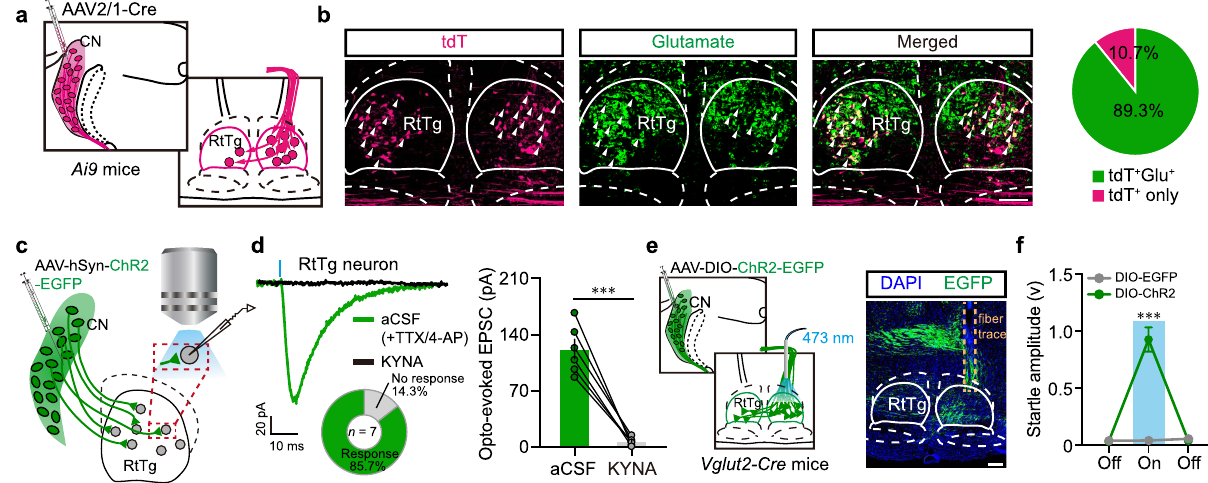
Fig. 5 The CN sends monosynaptic glutamatergic projections to RtTg glutamatergic neurons. a Schematic for the anterograde tracing from CN to RtTg. b Left: representative images showing RtTg tdT + neurons co-labelled with glutamate (white arrowheads). Scale bar, 300 μ m. Right: pie chart indicating the percentage of RtTg tdT + neurons co-labelled with or without glutamate. c Schematic for the optogenetic activation of CN neuronal terminals and the simultaneous whole-cell patch clamp recording of RtTg neurons. d Sample traces (left) and quantitative analysis (right) for EPSCs of RtTg neurons evoked by photostimulation (blue bar, 1 ms) before and after bath application of KYNA. TTX and 4-AP were added into aCSF ( n = 6 cells from 4 mice; P = 0.0003). The doughnut chart shows the percentage of RtTg neurons responsive or not responsive to the photostimulation. e Left: schematic for the optogenetic activation of CN glutamatergic neuron terminals in the RtTg. Right: a representative image showing EGFP + terminals in the RtTg. Scale bar, 300 μ m. f Startle amplitudes evoked by photostimulation of ChR2 + terminals or EGFP + terminals in the RtTg of Vglut2-Cre mice ( n = 15 stimuli from 5 mice per group; P = 7.76 × 10 − 7 ). Error bar represents mean ± s.e.m. Signi fi cance was assessed using two-sided paired t-tests in d , and two-sided unpaired t-tests in f . *** P < 0.001; ns, not signi fi